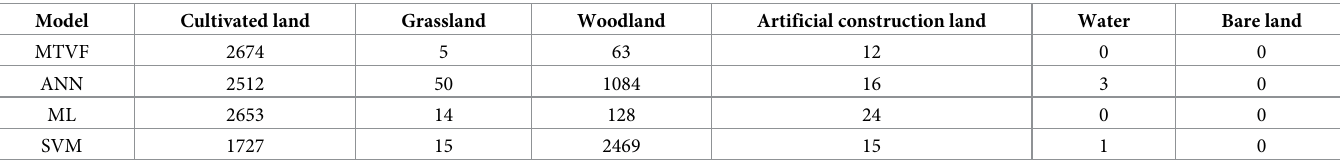
Table 9. Statistical comparison of the ground truth (pixels) of the MTVF and the other classification models.